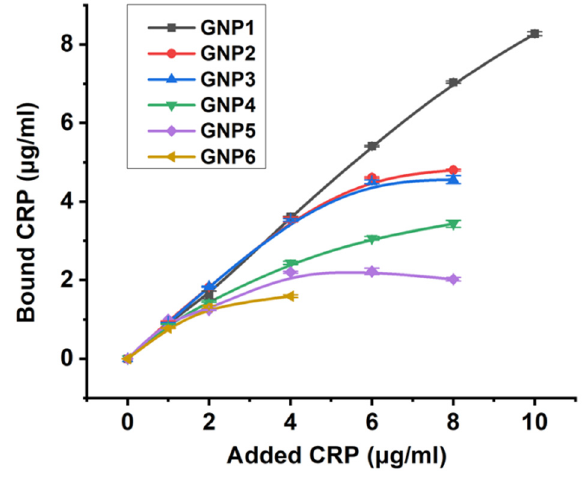
Figure 5. Calculated concentrations of CRP bound to conjugates of GNPs and antibodies ( y -axis) for conjugates of different diameters ( x -axis). Table 3. Calculated numbers of antigen-binding sites on one conjugate particle and their binding capacity.